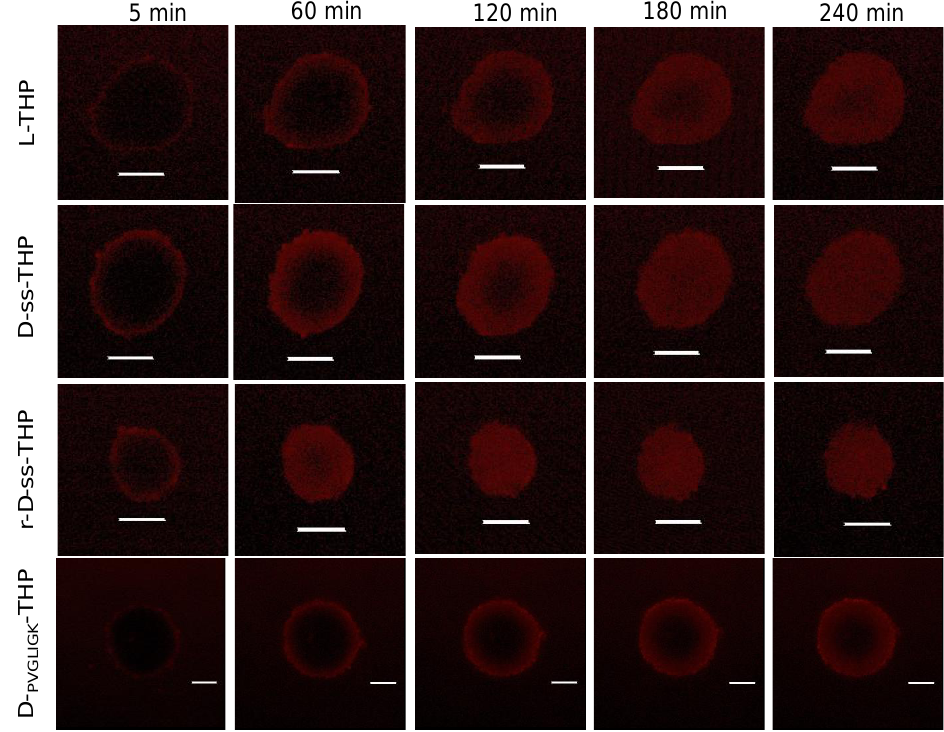
Figure 7. Penetration and cellular uptake of P-THP conjugates in cultured tumor cell spheroid. C26 cell spheroid of approximately 100 – 200 um in diameter was treated with different P-THP conjugates of 30 ug/mL (THP equivalent), and the drugs in spheroid were visualized by confocal laser microscopy. Scale bars = 100 um. The images are representative images of duplicated experiments. See text for details.